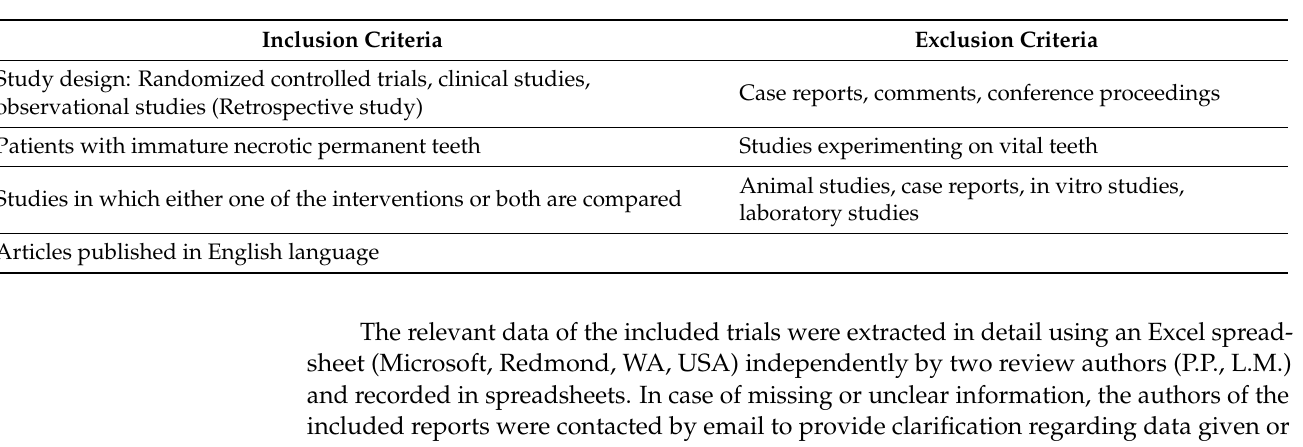
Table 2. Inclusion and exclusion criteria for selecting studies in the systematic